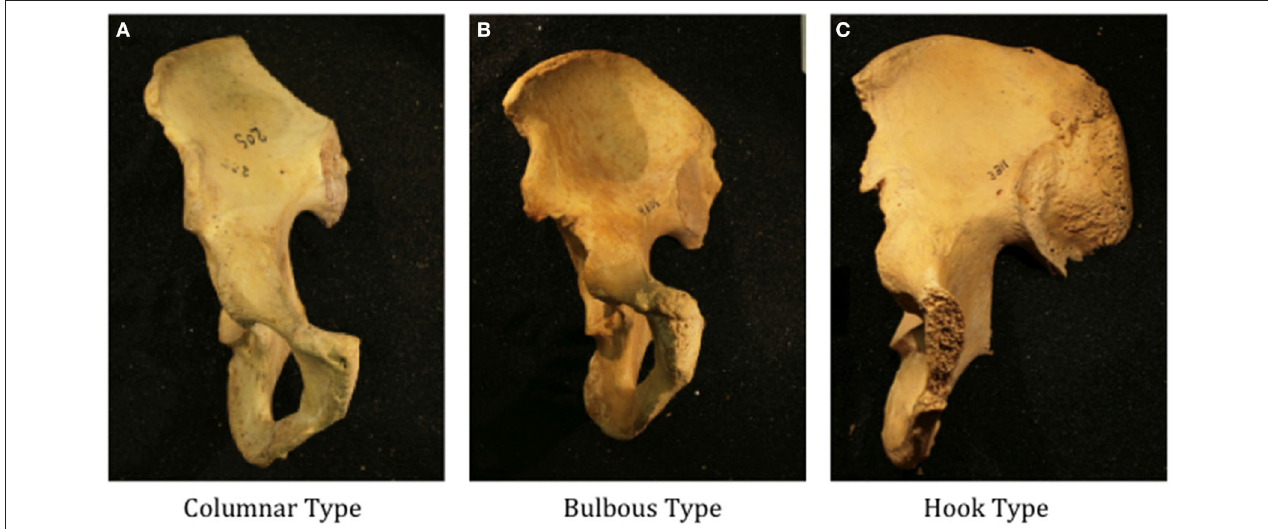
FIGURE 1 | Representative cadaveric hemi pelvises demonstrating subspine impingement subtypes based on anatomic morphology: (A) columnar, (B) bulbous and (C) hook.